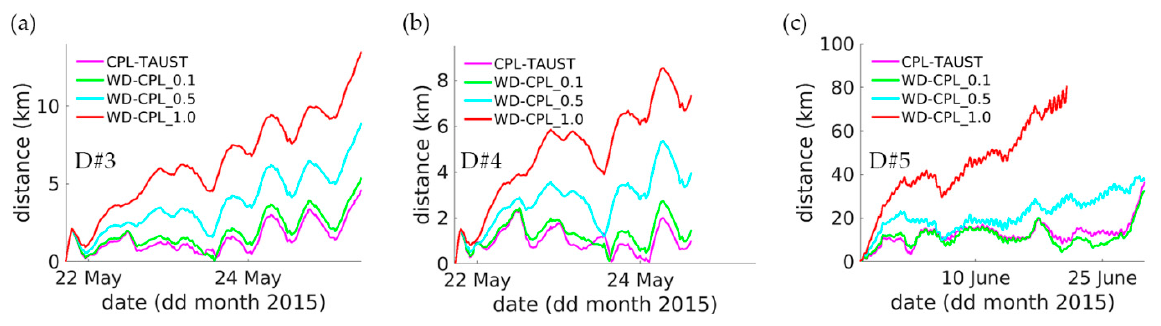
Figure 7. Time series of the separation distance (km) between the observed and model drifter #3 ( a ), #4 ( b ) and #5 ( c ) trajectories of WD-CPL experiments with wind drag contributions of 0.1, 0.5 and 1.0%.